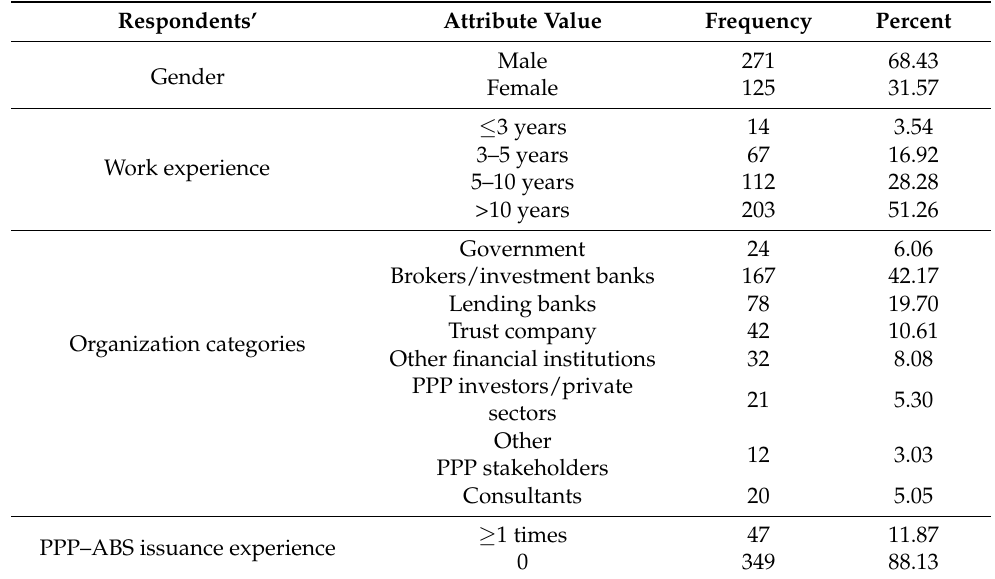
Table 4. Respondents’ information (Source: